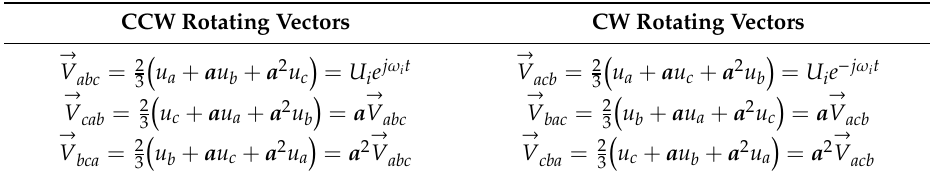
Table 1. The names and relationships defining the rotating voltage space vectors resulting in elimination of the CMV in three-to-three-phase